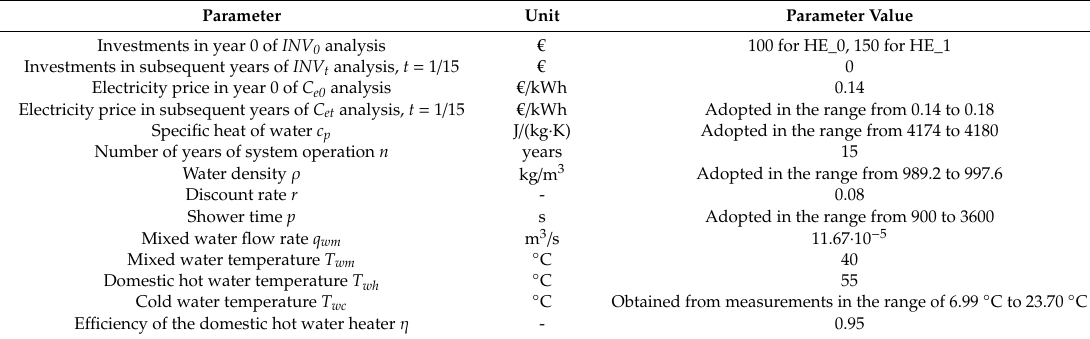
Table 2. Values of input parameters of the calculation model. Parameter Unit Parameter Value